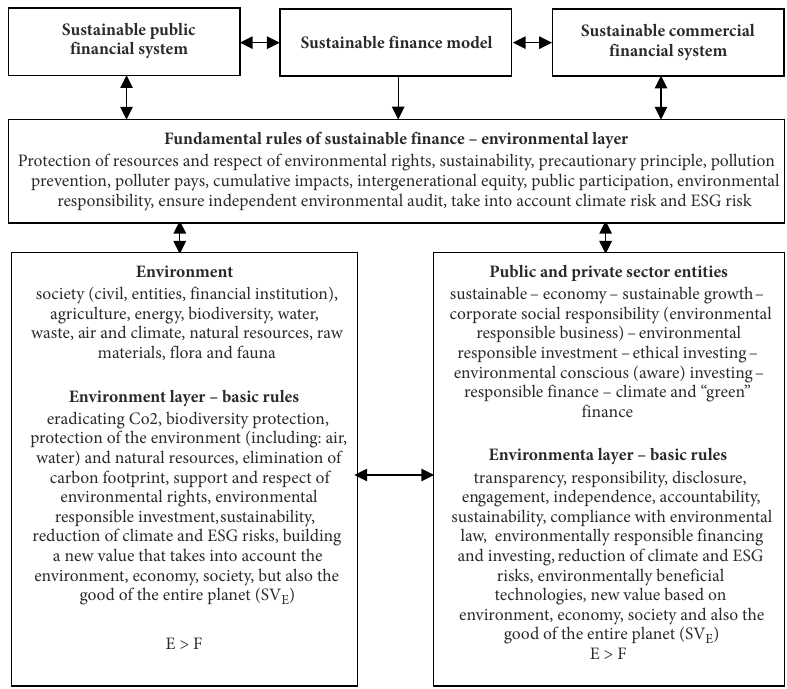
Figure 5. Triple layered sustainable finance model – environmental